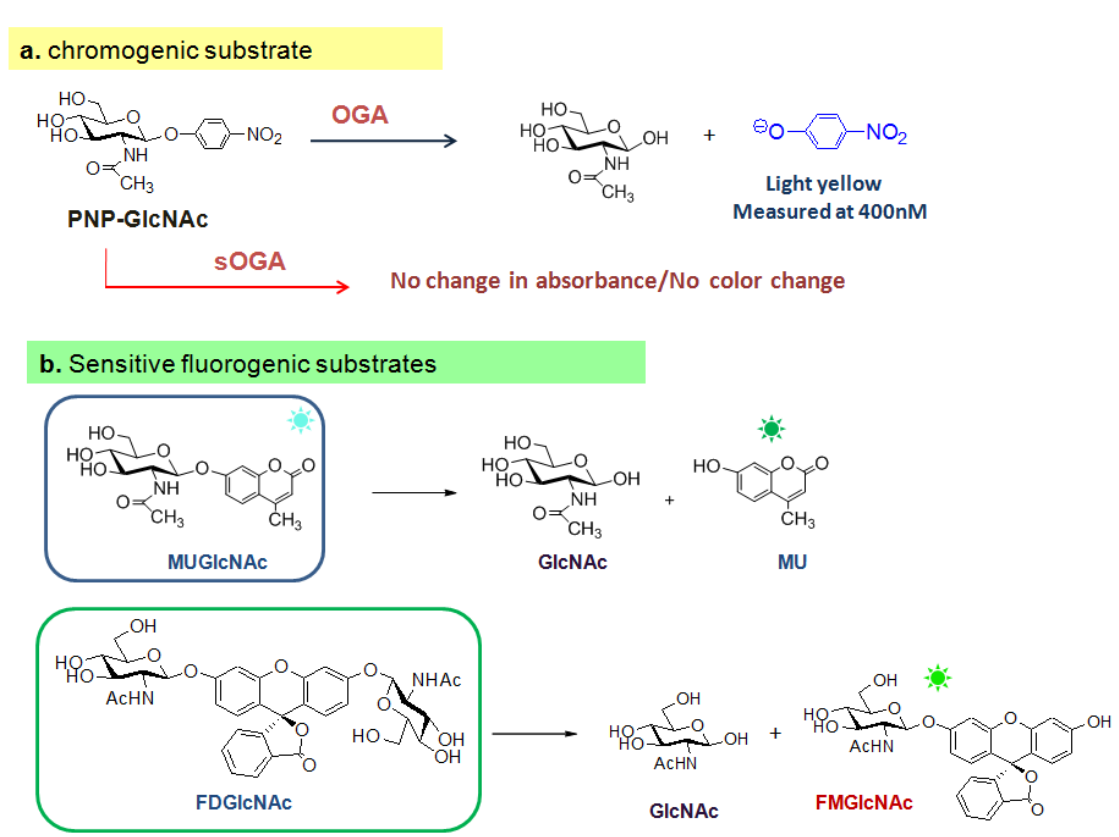
Figure 8. OGA activity assays using a chromogenic PNP-GlcNAc substrate (a) and two fluorogenic substrates